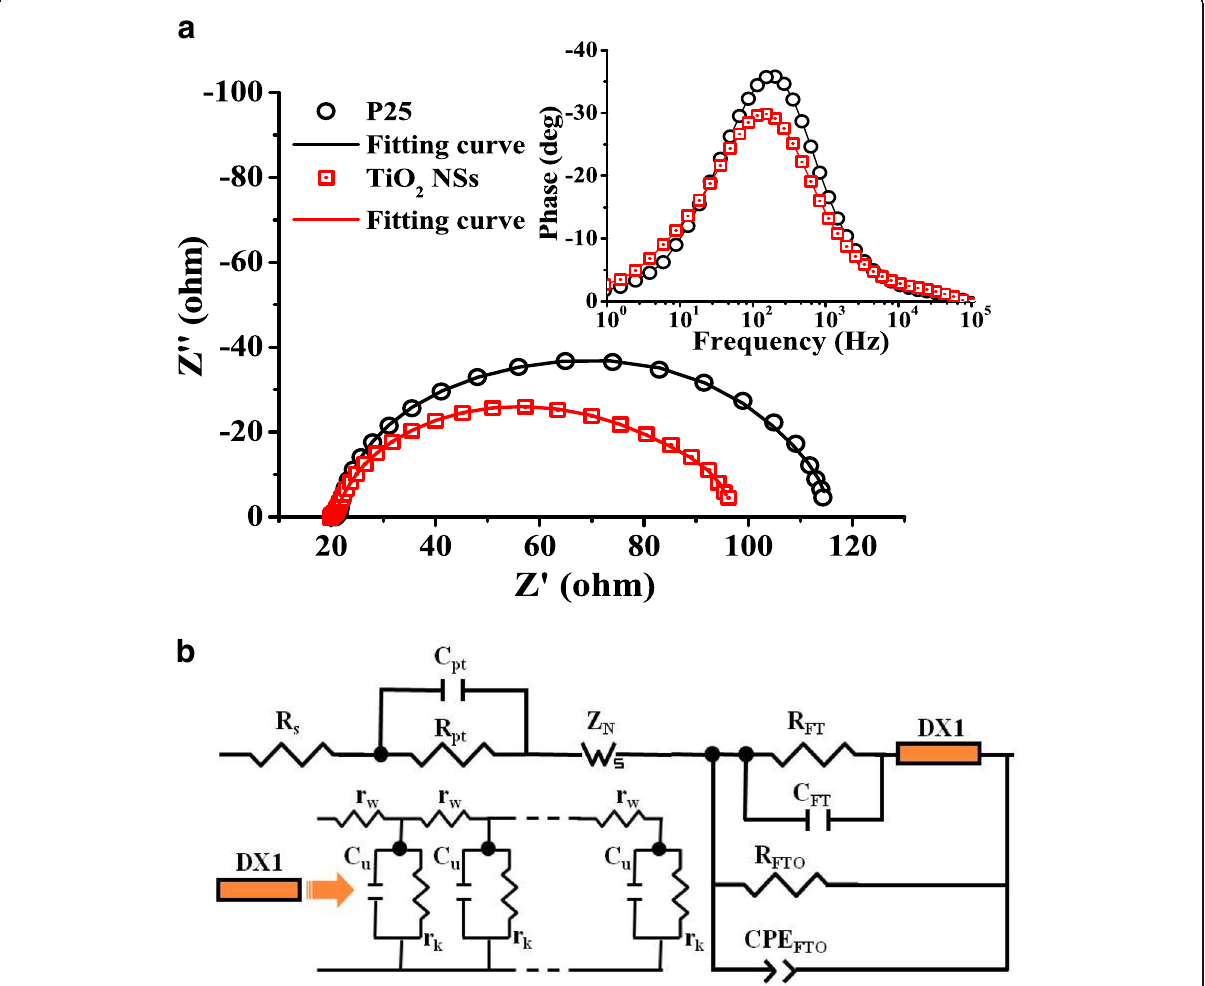
Fig. 6 a Nyquist plots of the TiO 2 NSs and P-25-based QDSSCs measured at V oc under one-sun illumination. Inset: the corresponding phase Bode plots. b The equivalent circuit of QDSSCs, where R s is the series resistance; R pt and C pt are the charge-transfer resistance and the interfacial capacitance at the Pt/electrolyte interface, respectively; R FT and C FT are the resistance and the interfacial capacitance at the FTO/TiO 2 contact, respectively; R FTO and CPE FTO are the charge transfer resistance and the constant phase element of the electric double layer at the FTO/electrolyte interface,